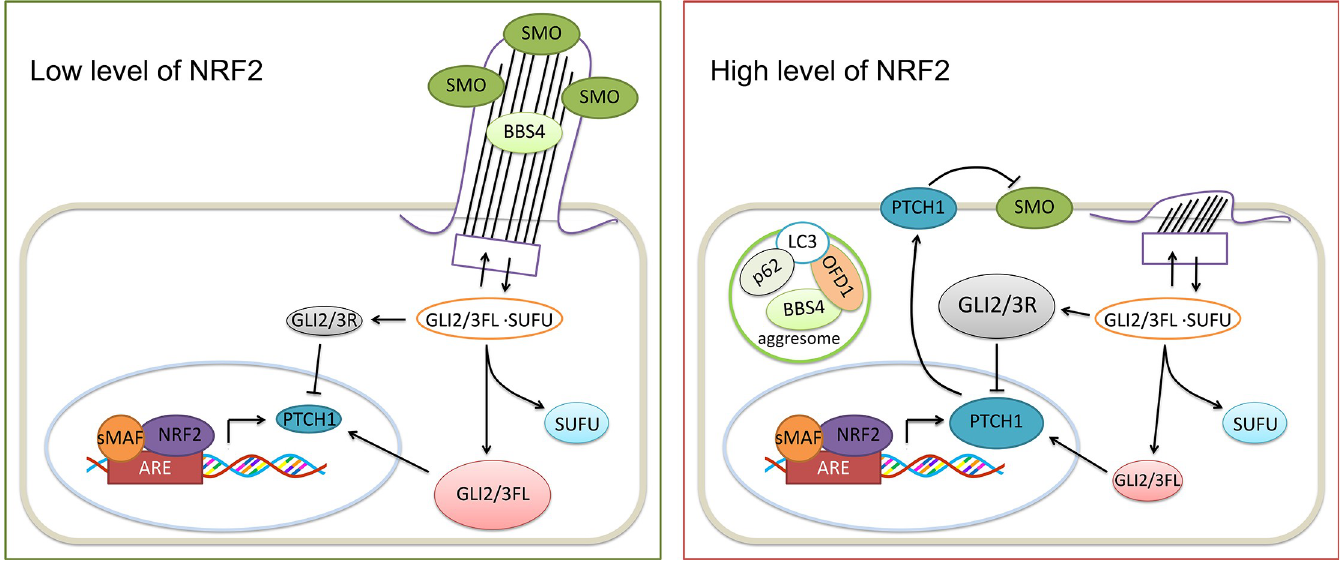
Fig 8. NRF2 suppresses Hh signaling through PTCH1 and primary ciliogenesis via p62. Deletion of NRF2 down-regulated PTCH1, increased primary cilia formation, and activated Hh signaling, all of which can be reversed by NRF2 up-regulation. Moreover, NRF2 suppressed primary cilia formation through p62-dependent aggresome formation and blockage of BBS4 ciliary entrance. ARE, antioxidant response element; BBS4, Bardet–Biedl syndrome 4; FL, full-length activator; Hh, hedgehog; LC3, microtubule-associated proteins 1A/1B light chain 3B; NRF2, nuclear factor-erythroid 2-like 2; OFD1, oral–facial–digital syndrome 1; PTCH1, Patched 1; R, repressor; sMAF, small MAF Transcription Factor; SMO, smoothened; SUFU, suppressor of fused homolog.